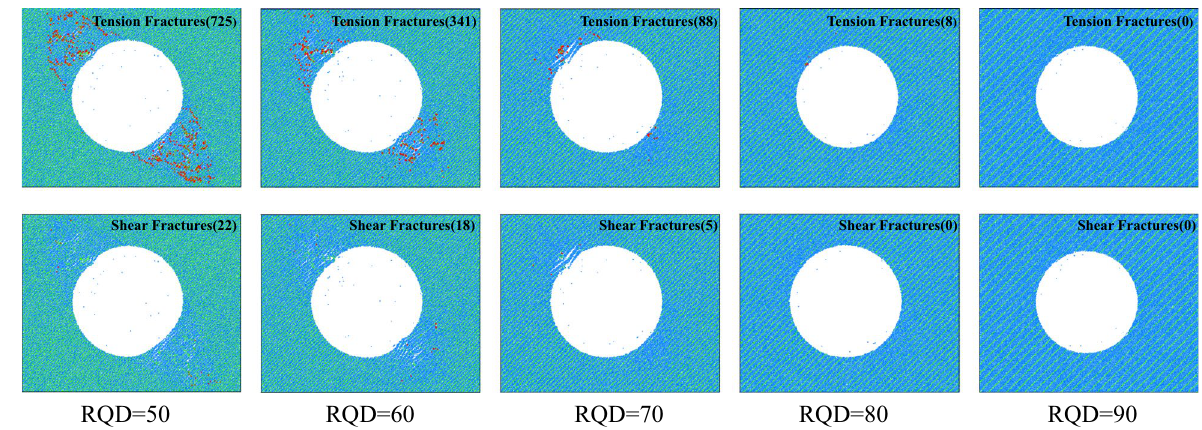
Fig. 18 Failure results of different RQD values (for σ